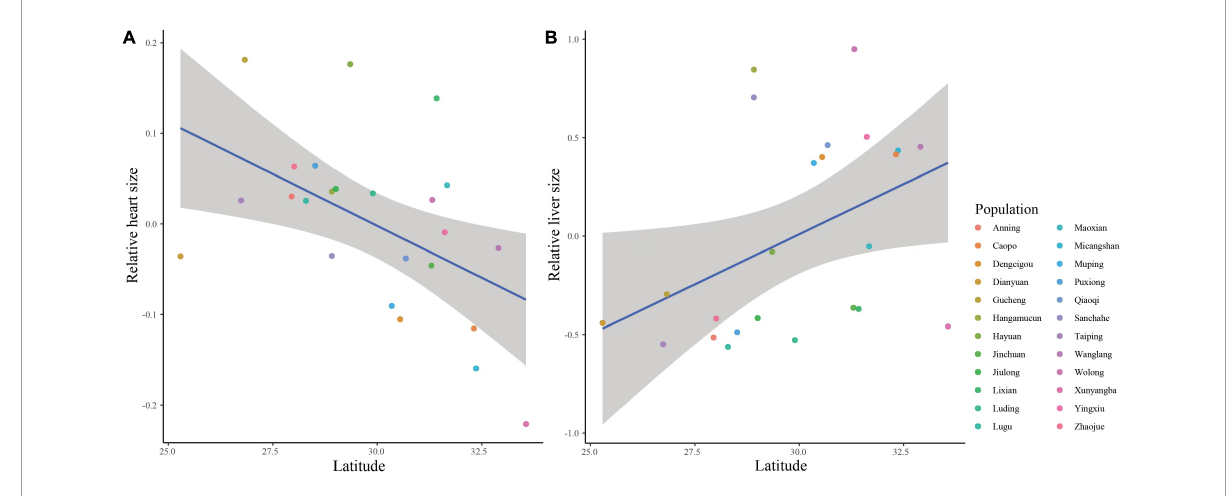
FIGURE2 The relationships between latitude and relative size of heart (A) and livers (B) in Bufo andrewsi among 24 populations.